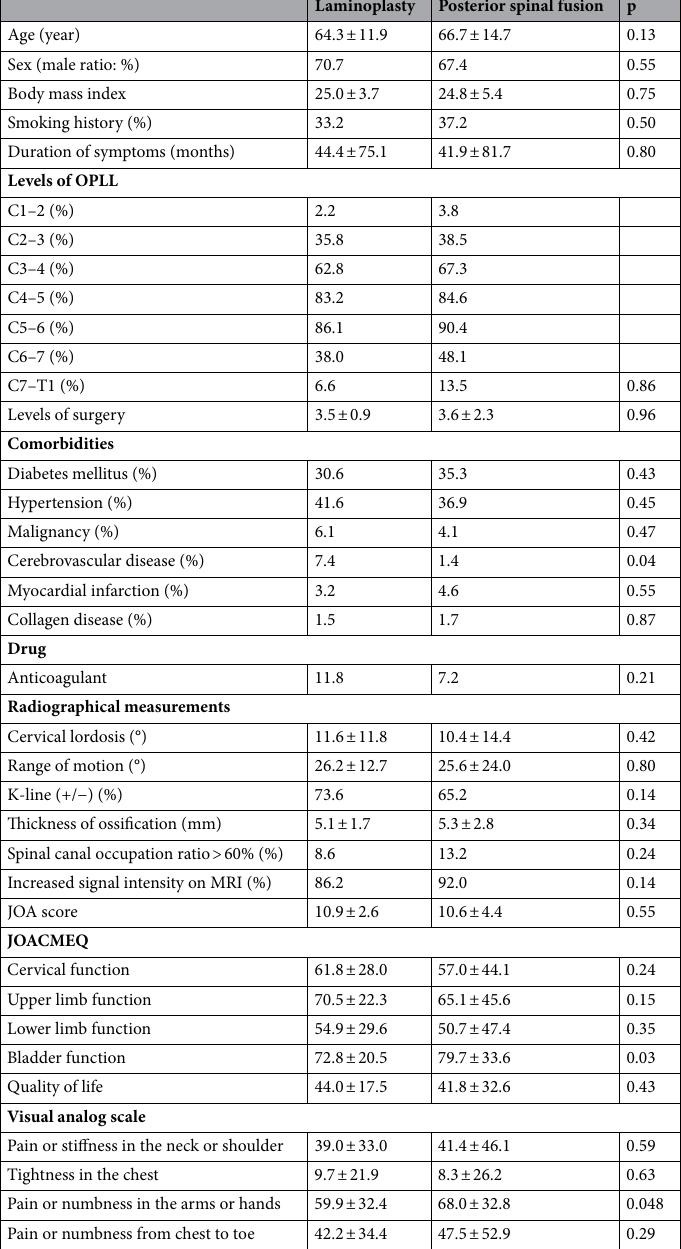
Table 2. Demographic parameters, preoperative radiographical parameters, and quality of life in the weighed sample of patients undergoing laminoplasty or posterior spinal fusion. Summary statistics for continuous variables are means and standard deviations. JOA Japanese Orthopedic Association, JOACMEQ Japanese Orthopaedic Association Cervical Myelopathy Evaluation Questionnaire, MRI magnetic resonance